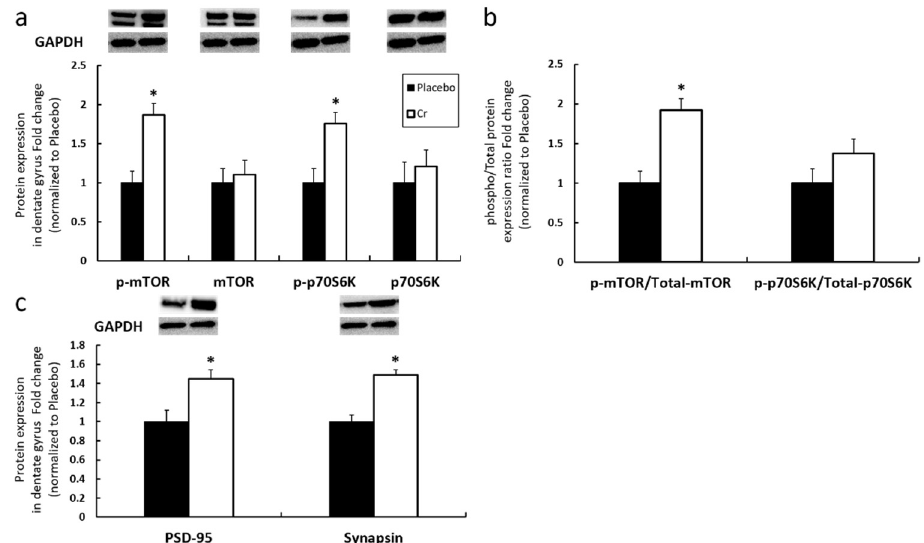
Figure 6. Effects of 6 weeks of Cr supplementation on molecular signaling in dentate gyrus without LPS. ( a ) Proteins expression level of mTORC1 signaling pathway targets. ( b ) Ratio of phosphorylation/total mTORC1 signaling proteins. ( c ) synaptic proteins downstream of mTORC1 signaling. Results are presented as mean ± SEM ( n = 8). * p < 0.05 significantly different from placebo group.